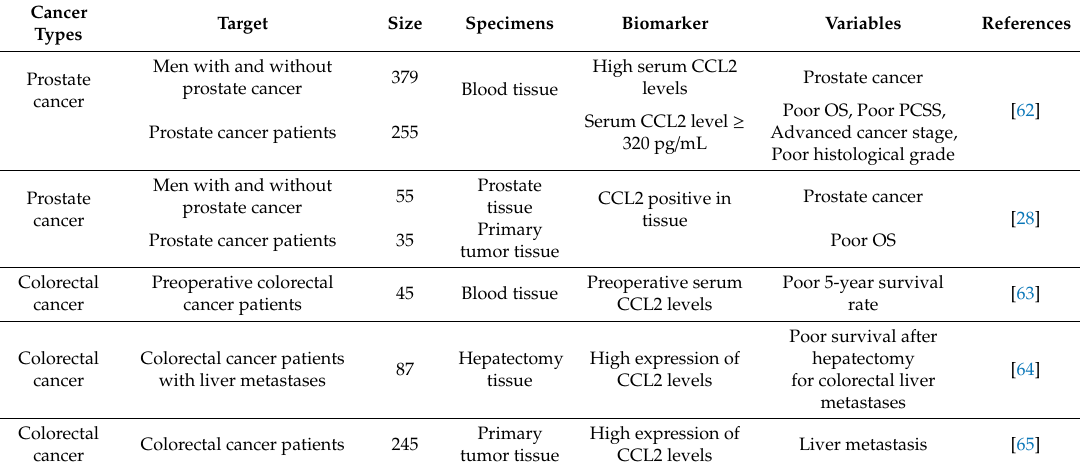
Table 1. Role of CCL2–CCR2 axis as a biomarker in various